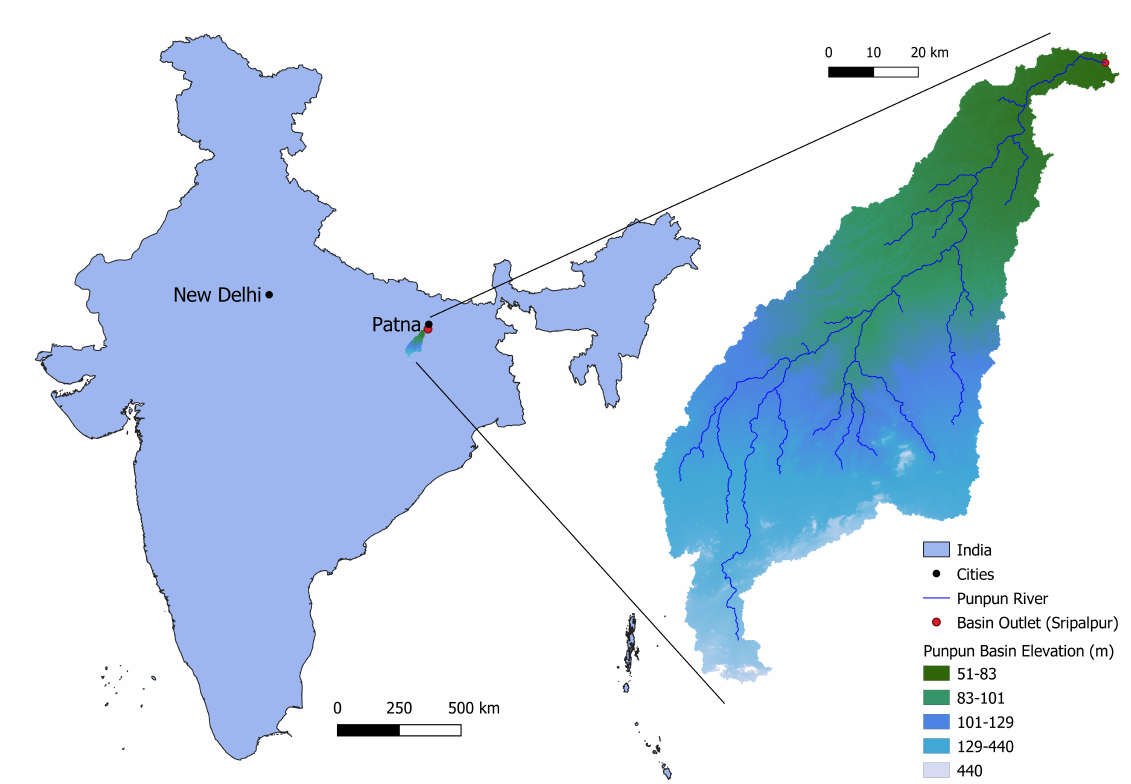
Figure 1. Study area (Punpun River Basin): Topographic map showing the Digital Elevation Map (DEM) with elevation in meters above mean sea